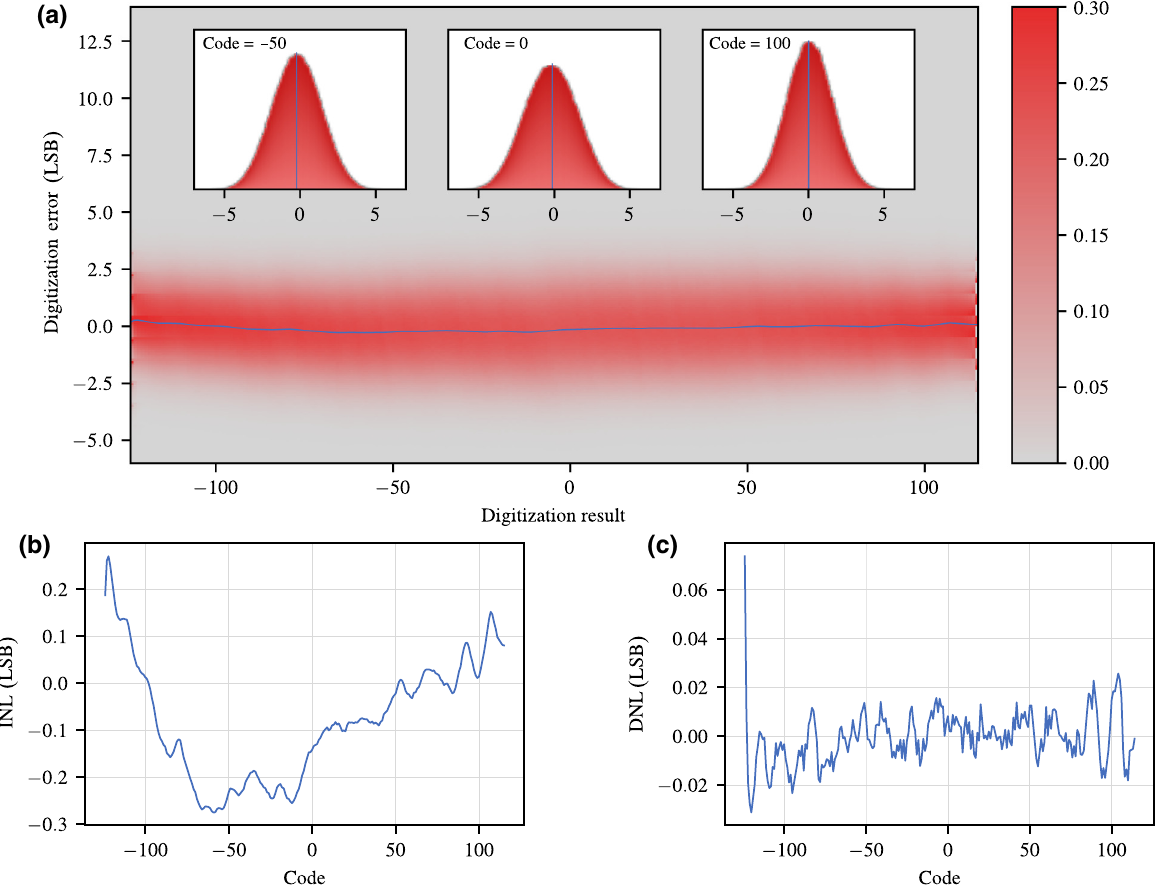
FIG. 6. (a) A heat map of the errors present in the captured sine wave. The inset shows the distributions for the codes − 50, 0, and 100. The blue line represents the INL, i.e., the mean of the errors for each digitization result. (b) The integral nonlinearity versus the ADC code. (c) The differential nonlinearity versus the ADC